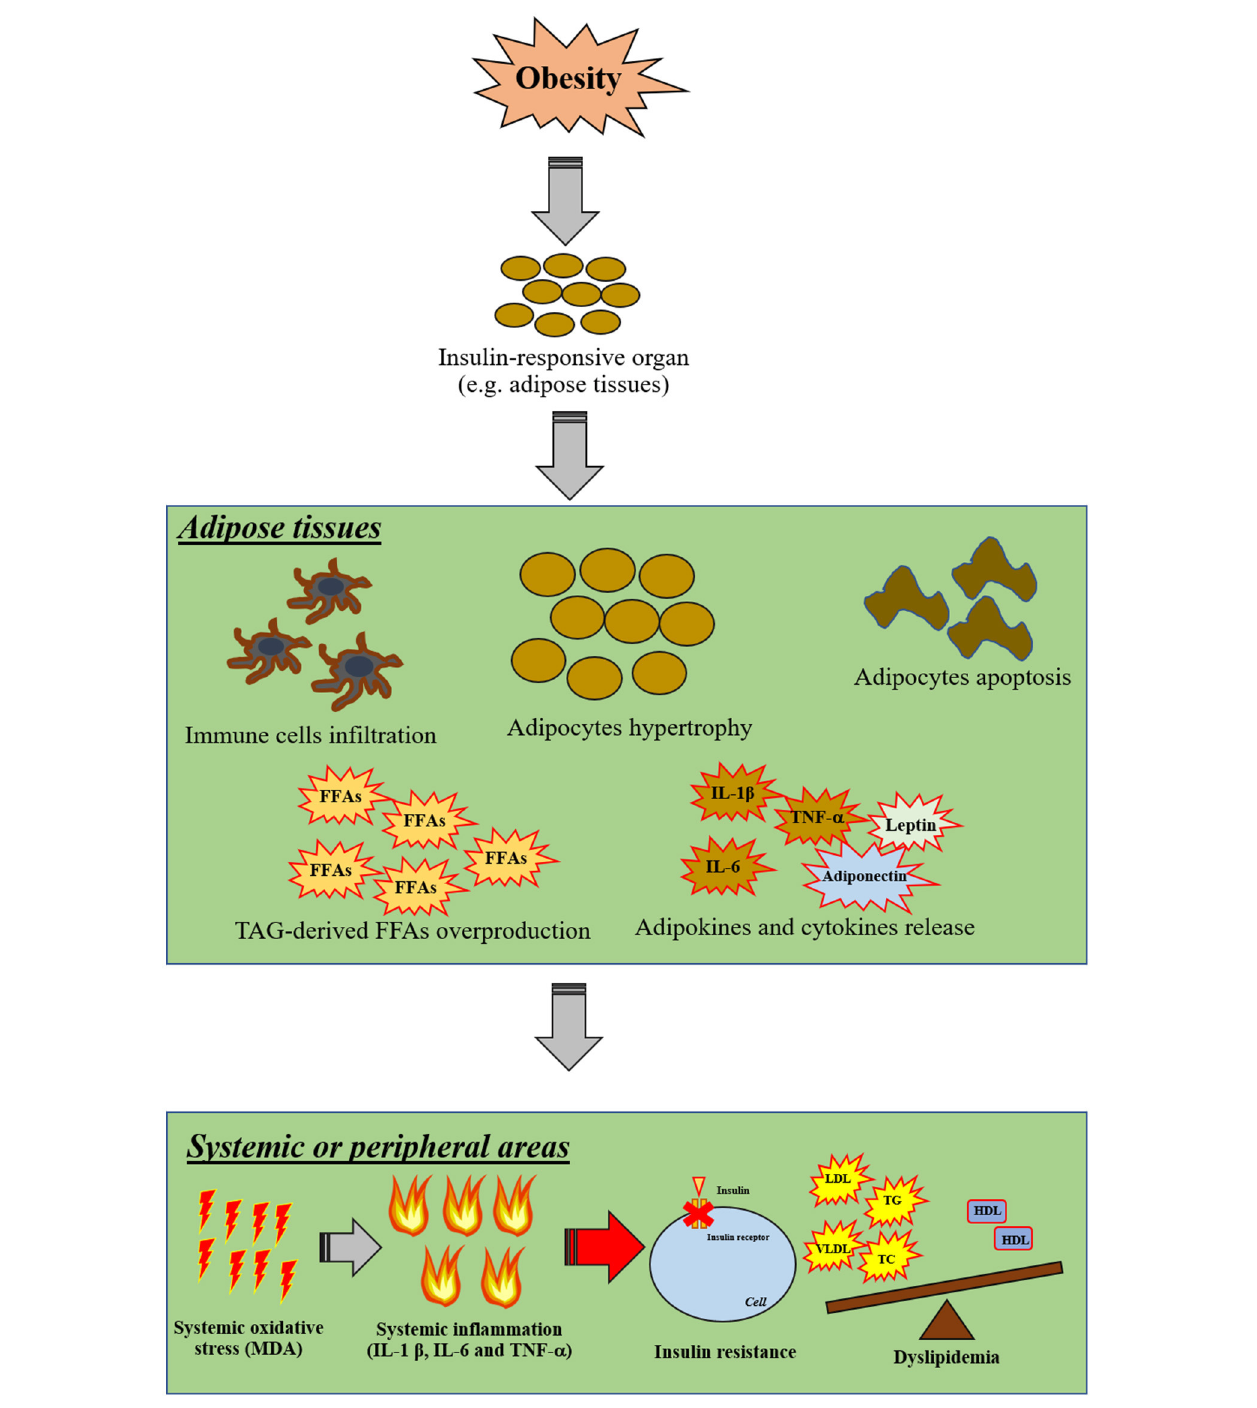
FIGURE 2 | The proposed mechanisms of insulin resistance in obesity via inflammation and oxidative stress. Obesity primarily affects insulin-responsive organs particularly in adipose tissue by inducing adipocyte hypertrophy, adipocyte apoptosis, infiltration of immune cells, TAG-derived FFA overproduction and promoting the release of pro-inflammatory cytokines. Moreover, excessive FFA can also induce oxidative stress in adipose tissue. After that, cellular oxidative stress can induce systemic oxidative stress and further promote systemic inflammation. As a result, these systemic pathological conditions can impair cellular insulin signaling in other organs in association with the induction of dyslipidemia by excessive FFA production from adipose tissues. FFAs, free-fatty acids; HDL, high-density lipoprotein; IL, interleukin; LDL, low-density lipoprotein; MDA, malondialdehyde; TAG, triacylglycerol; TC, total cholesterol; TG, triglyceride; TNF, tumor necrosis factor; T2DM, type-2 diabetic mellitus; VLDL, very low-density lipoprotein; WAT, white-adipose tissue.